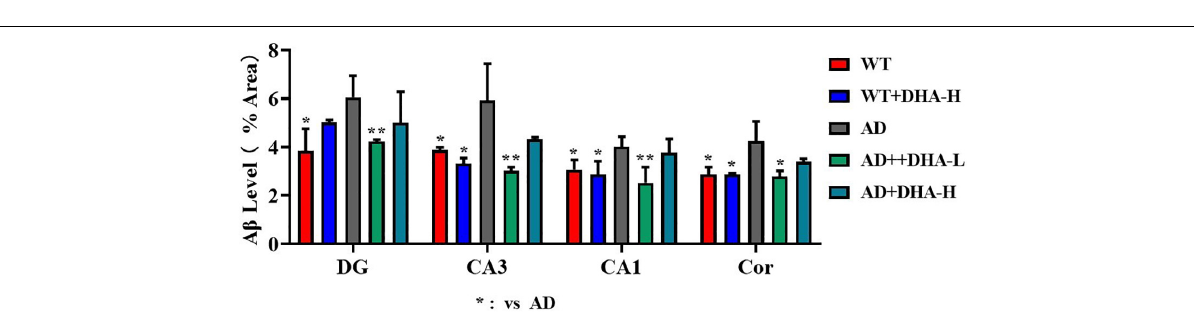
FIGURE 11 | Effects of DHA treatment on A β level in the brain in 2 × Tg AD mice. * p < 0.05, ** p < 0.01. Error bars represent mean ± S.E.M. ( n =